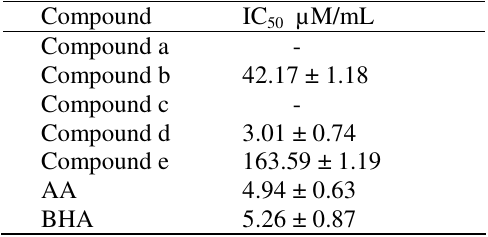
Table 1. 50% Inhibition of DPPH radical by the analogues of dibenz[ b,f ]azepine.